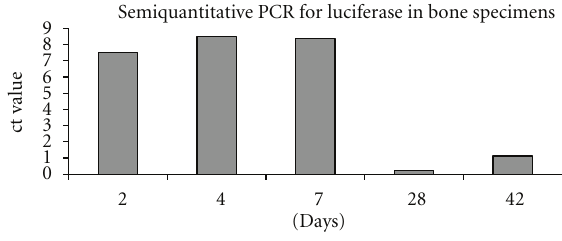
Figure 5: Semiquantitative PCR results of luciferase in bone specimens after 2, 4, 7, 28, and 42 days. Transfection in the bony specimens was highest at day 2, 4, and 7. At days 28 and 42 only low amounts of luciferase were